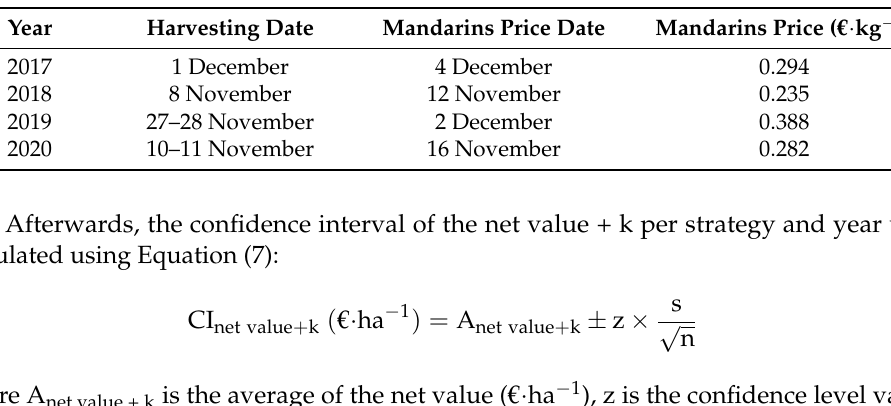
Table 3. Average prices of ‘Clemenules’ citrus fruit at the corresponding harvesting dates for each trial season in Valencia